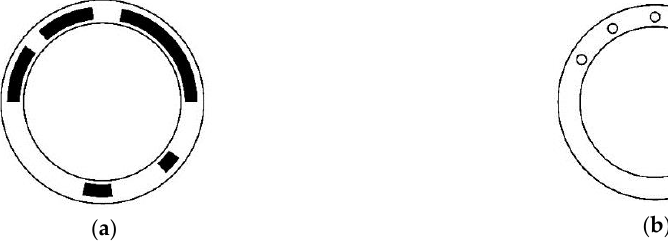
Figure 4. Disc pattern and reading head distribution of absolute encoder using a length-6 period-36 necklace ordering STGC. ( a ) Schematic of the coding disc, where the white area indicates “0”, and the black area indicates “1; ( b ) Schematic of the reading disc, where the six small circles denote the six reading heads and are evenly distributed around the half coding track.